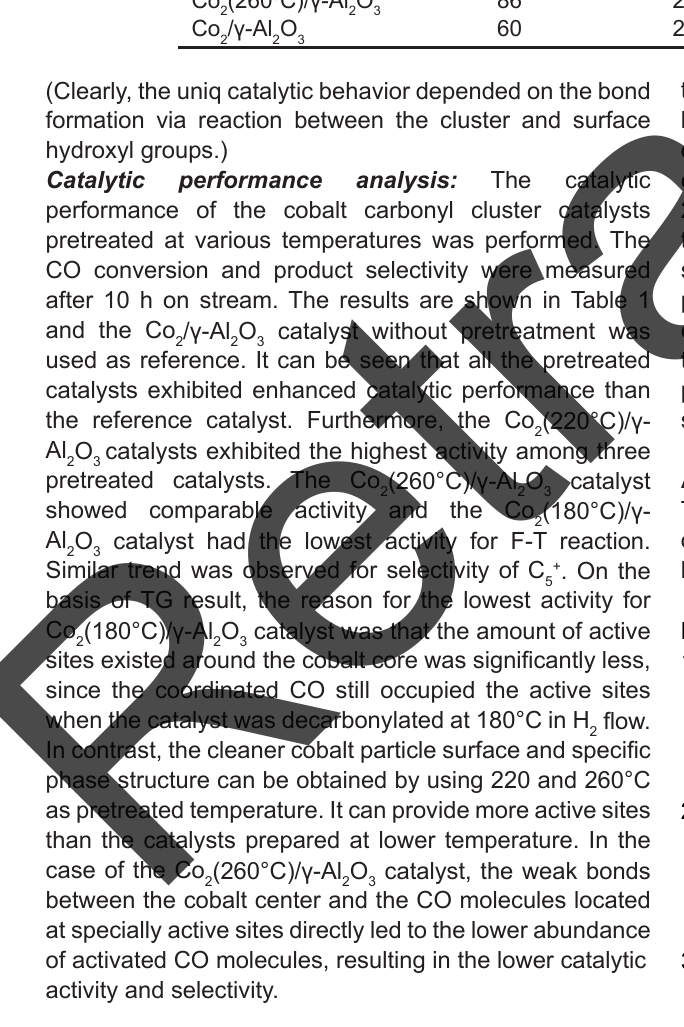
3. IR spectra (KBr pellet) of the samples: (a) pure crystalline precursor (CO) Table 1. Catalytic performance of the catalysts for F-T synthesis reaction, % Catalysts CO